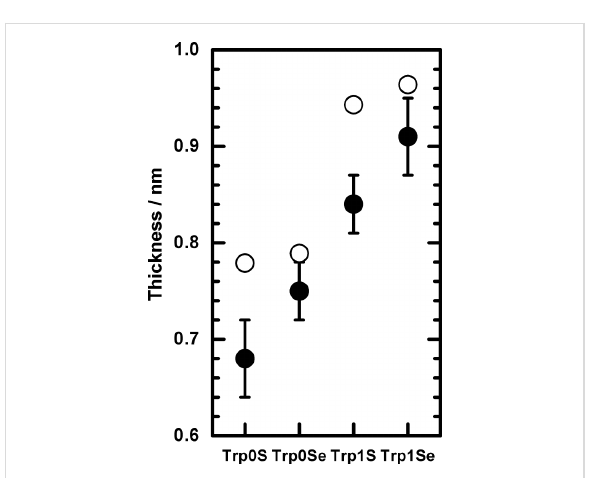
Figure 4: Thicknesses of the Trp0S, Trp0Se, Trp1S and Trp1Se monolayers on Au(111) determined from the evaluation of the XPS data ( ● ) and theoretical maximum monolayer thicknesses ( ○ ) (see